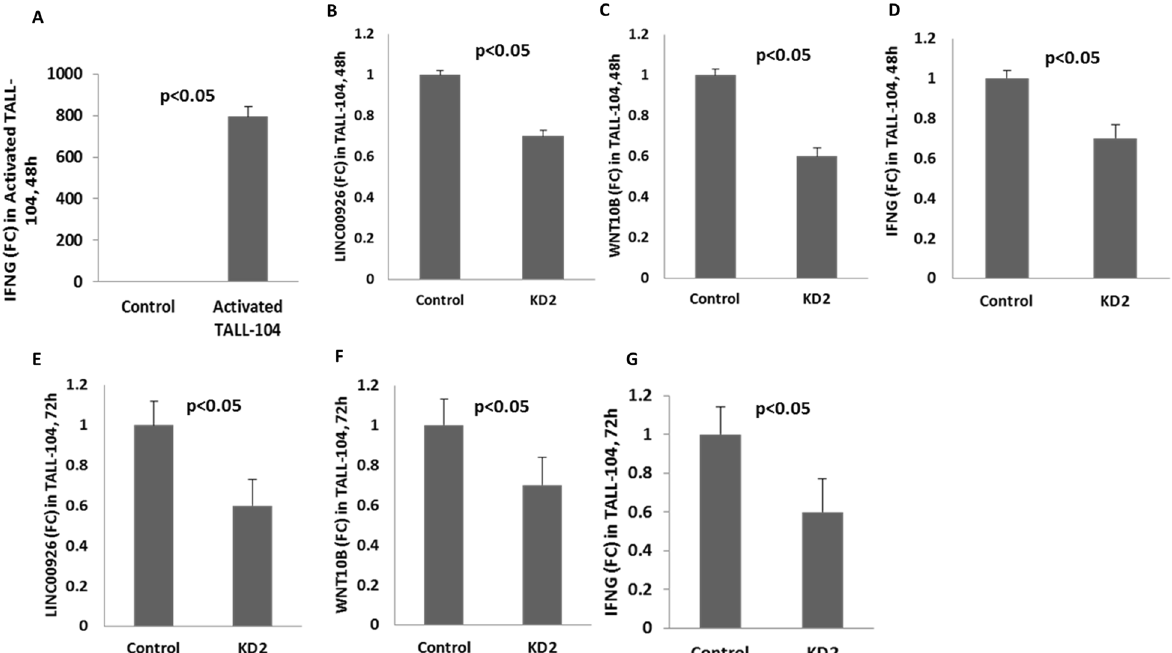
Fig. 5 Regulation of IFNG expression by WNT10B in TALL-104 cells. To con fi rm that WNT10B regulated IFNG as a result of the role played by LINC00926 in T cells, TALL-104, a human lymphoblastic cell line known to express IFNG was used. LINC00926 was knocked down in these cells using siRNA and WNT10B and IFNG were measured by qRT-PCR at the indicated time points. Induction of IFNG in activated TALL-104 ( A ). Effect of knocking down of LINC00926 ( B 48 h, and E 72 h) on WNT10B at different times ( C 48 h and F 72 h) and on IFNG levels ( D 48 h and G 72 h), as measured by qRT-PCR. KD2: 2nd Knockdown, representing the siRNA used.